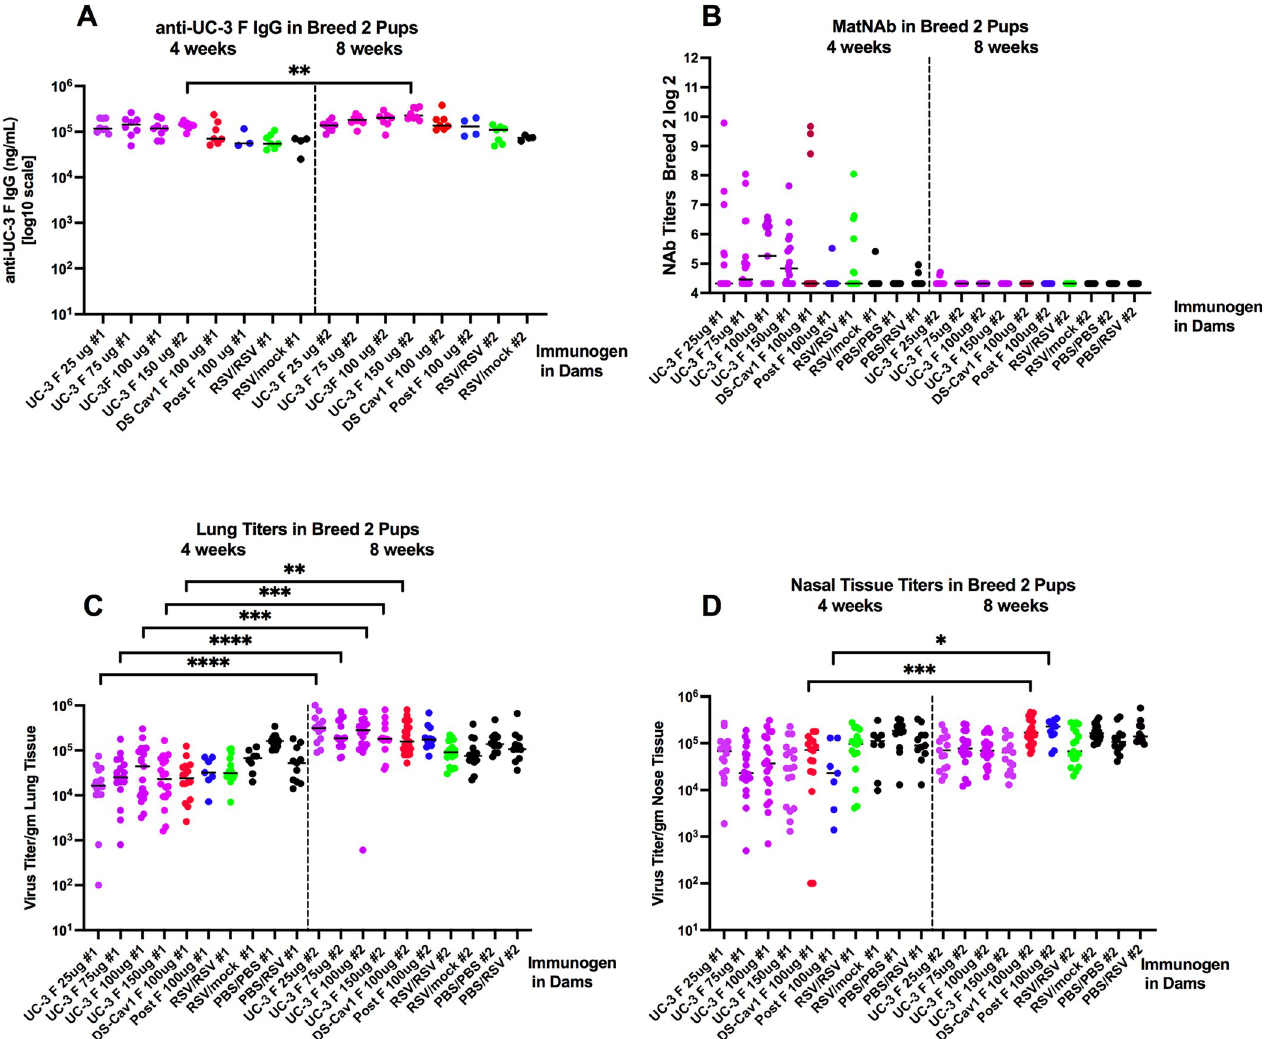
Fig 8. Durability of protection in breed 2 offspring. Sera and tissues acquired at 4 weeks or 8 weeks after birth of breed 2 pups were assessed for total anti- pre-F IgG (panel A), NAb titers (panel B), RSV lung titers (panel C) or nasal tissue titers (panel D) after RSV challenge; Significant differences between matching groups (offspring of dams immunized with the same VLP at the same dose) were identified by one way ANOVA followed by post-hoc Sıˆda´k multiple comparisons test � p < 0.05; �� p < 0.01; ��� p < 0.001; ���� p <